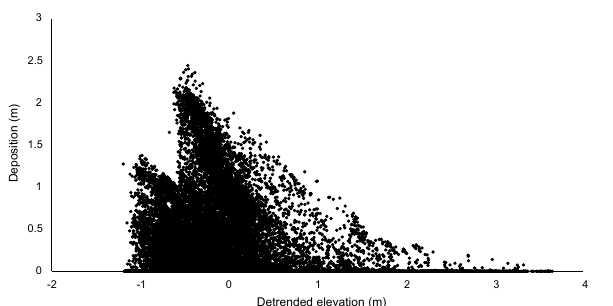
Figure 3. Sediment thicknesses for each 5m pixel of study reach versus detrended bed